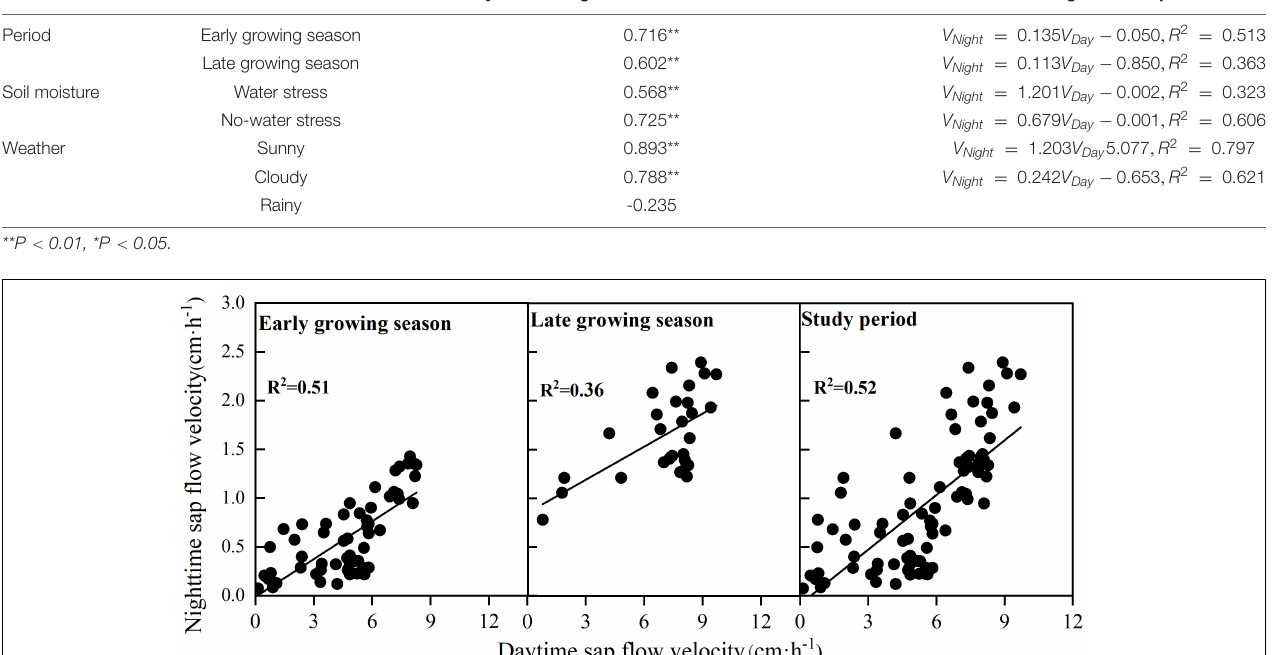
TABLE 5 | Relationship between daytime and nighttime sap flow velocity under different soil moisture and weather conditions. Different conditions